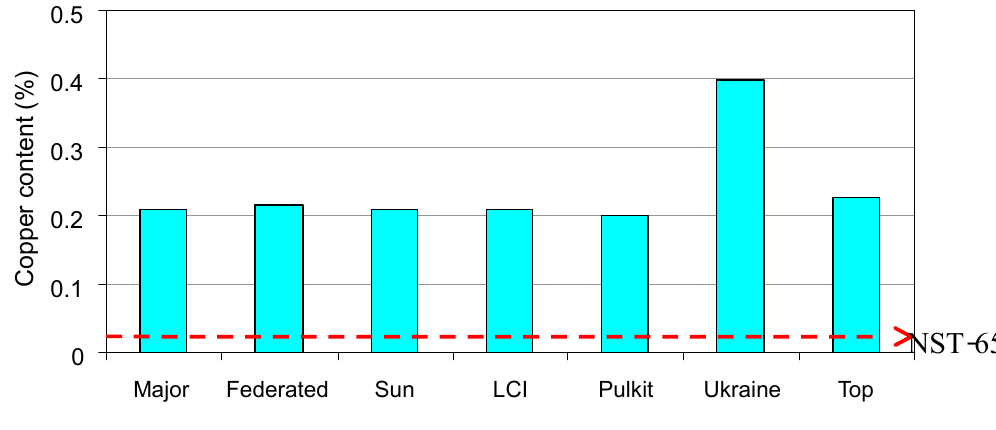
Fig. 7. Copper (Cu) contents in steel specimen.